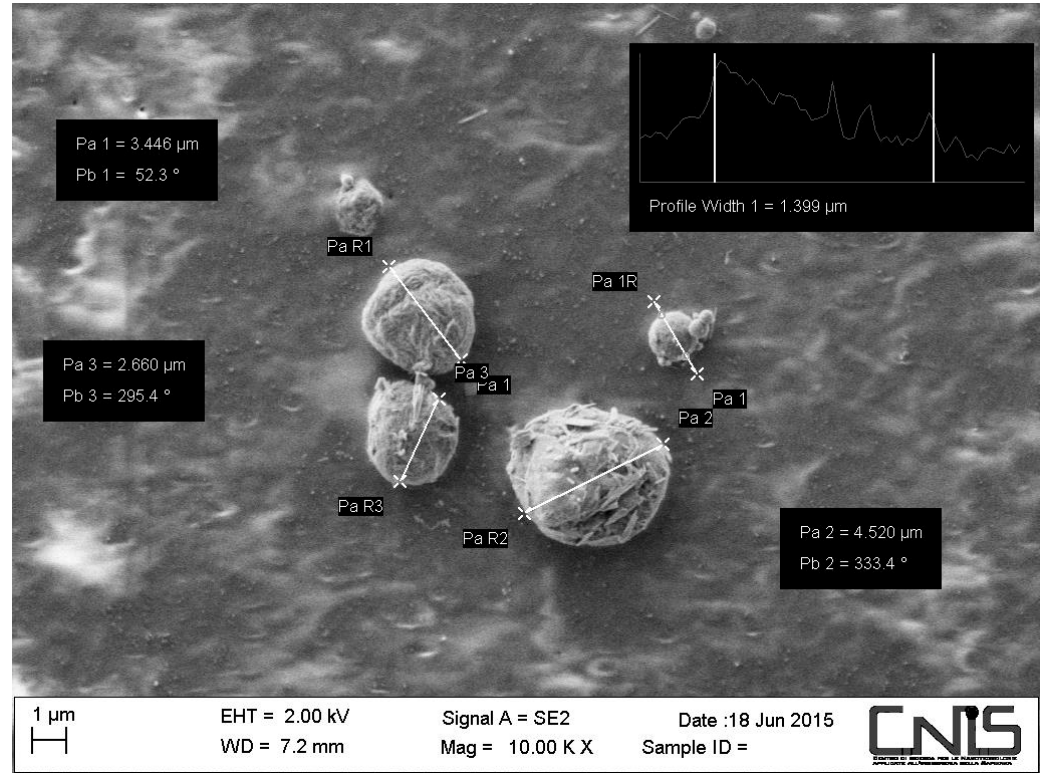
Figure 1. Morphology of the Chitin Nanofibril bio-Lignin micro/nanoparticles at SEM microscopy. Magnification 1000KX. From: Morganti et al. J. of Clinical and Cosmetic Dermatology Vol.1:1, 2017; Open Access [22].